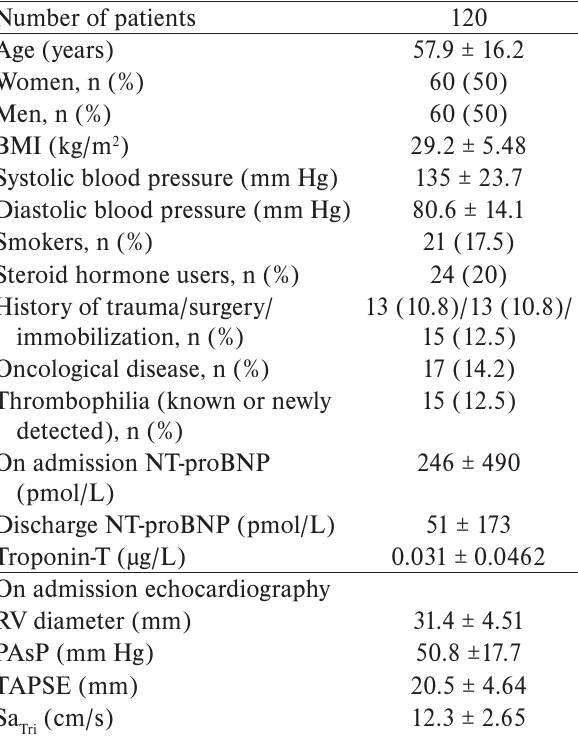
Table 2. Baseline characteristics of study